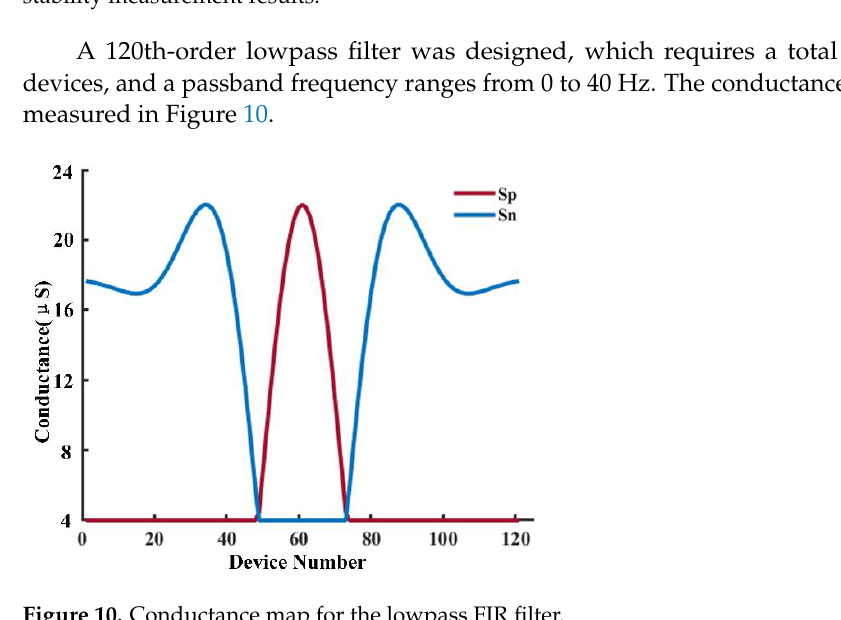
Figure 11. Simulated EEG raw data and filtered results. Table 1. Performance comparison with the published work. [14]